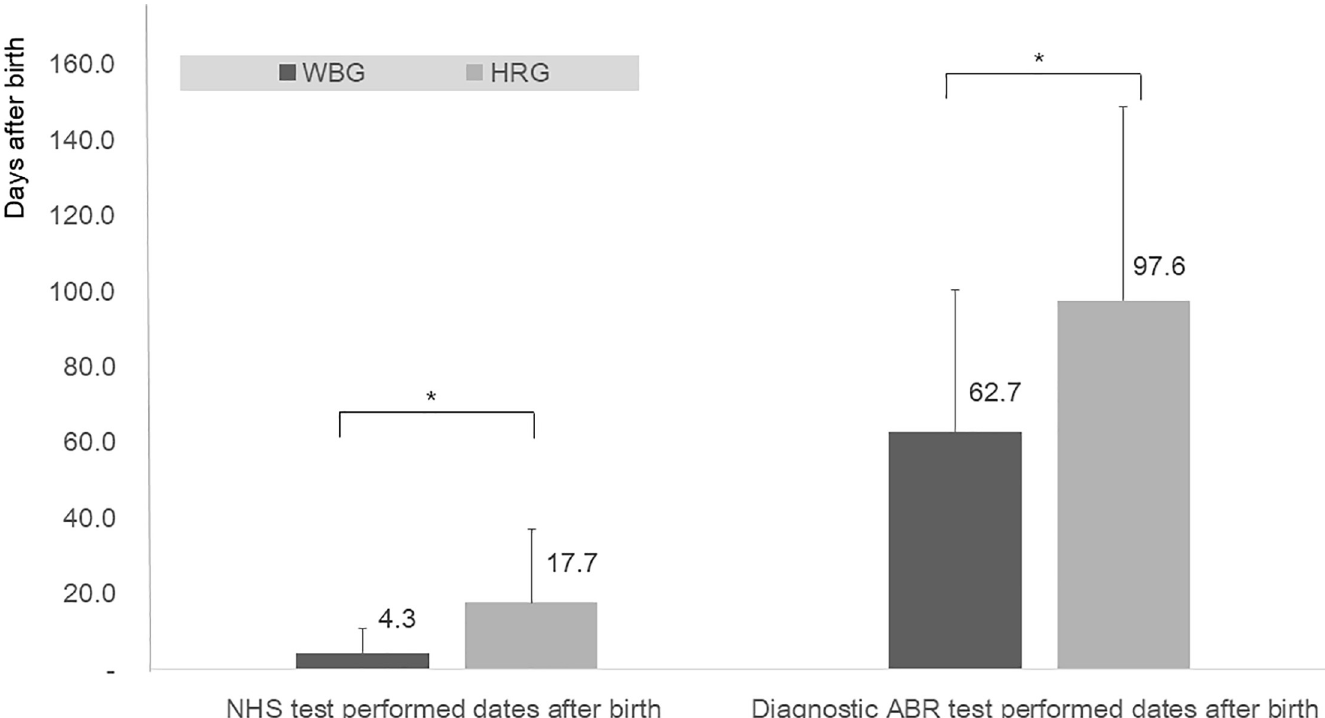
Fig 4. Performed dates of hearing screening test (A) and the diagnostic test (B) in well-baby group (WBG) and high-risk group (HRG). In WGB, the average screening tests were performed 4.3 ± 6.7 days after birth and the referred infants were diagnosed with ABR 62.7 ± 37.5 days after birth. In HRG, the average screening tests were performed 17.7 ± 19.3 days after birth and the referred infants were diagnosed with ABR 97.6 ± 51.4 days after birth. In the WBG, both screening and confirmatory tests were performed significantly earlier than those of HRG. � : p < 0.05 ( p < 0.0001 in screening test and p = 0.0102 in diagnostic test, Wilcoxon rank sum test).